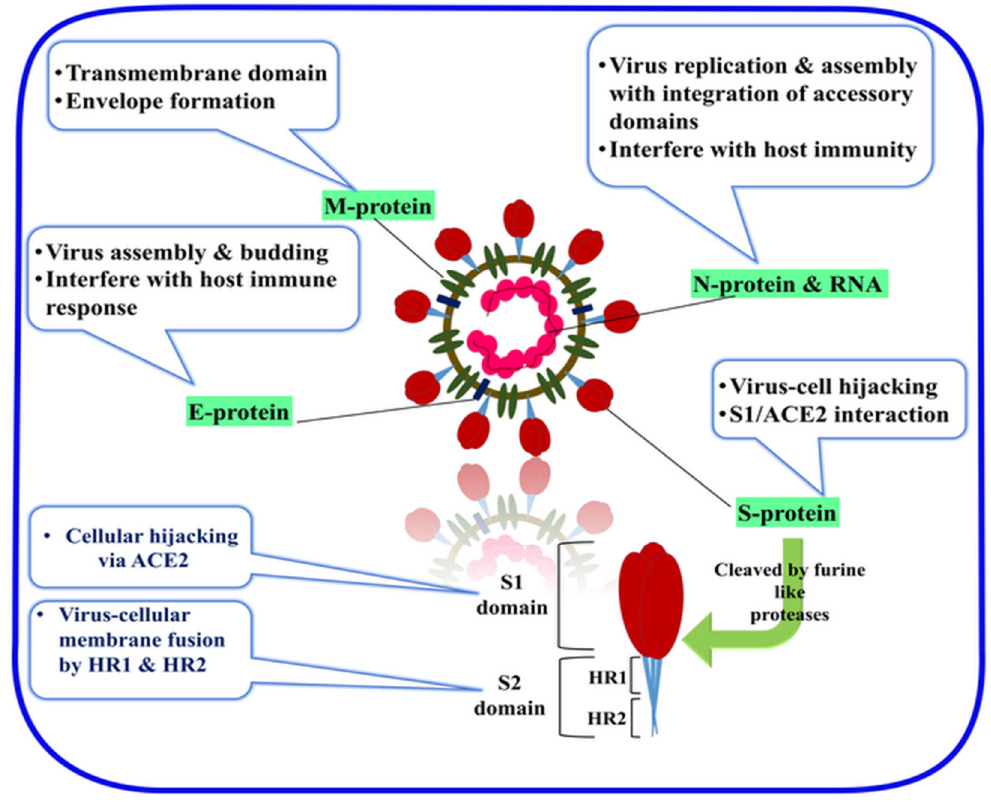
Figure 4. SARS-CoV-2 structural proteins, including membrane (M), envelope (E), nuclear (N), and spike Figure 4. SARS‐CoV‐2 structural proteins, including membrane (M), envelope (E), nuclear (N), and (S) proteins. S protein cleaved by the host proteases into S1 and S2 spike (S) proteins. S protein cleaved by the host proteases into S1 and S2 domains.